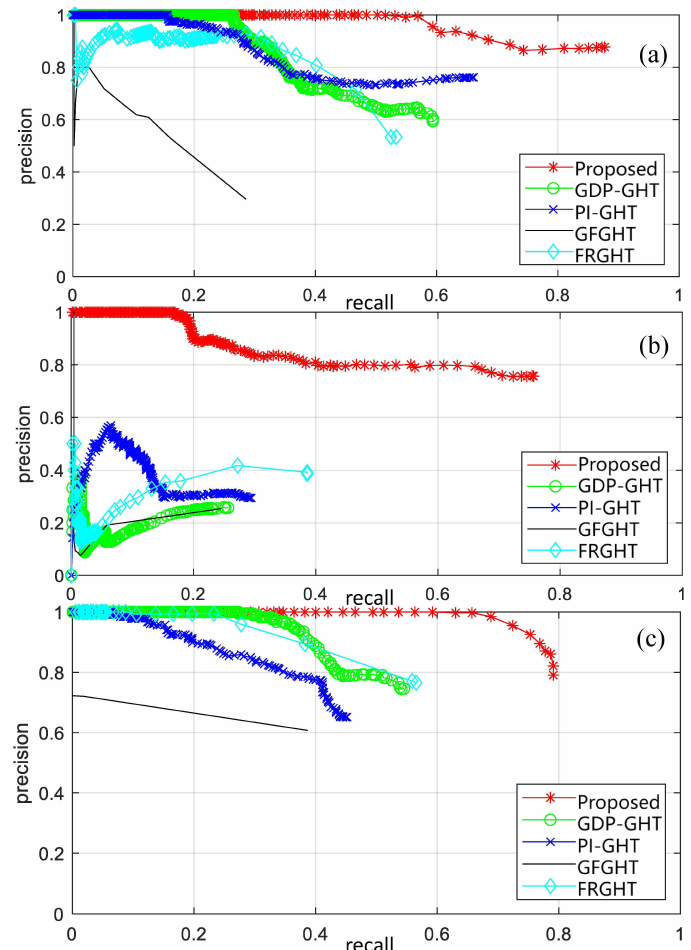
Figure 15. Precision vs. recall for ( a ) centre, ( b ) rotation, and ( c ) scaling estimation using the Monte Carlo